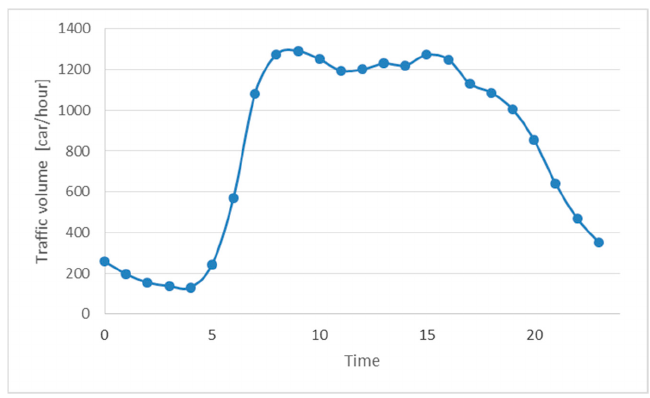
Figure 5. Traffic volume from previous years measured in the vicinity of the Daszynskiego roundabout.